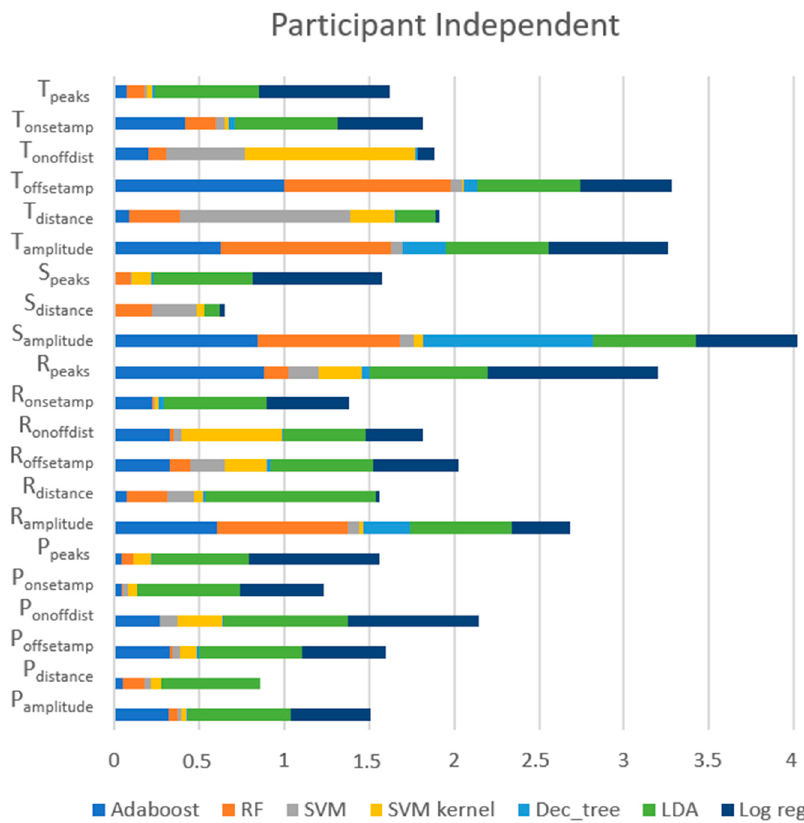
Figure 13. Importance of features for each model using the participant-independent approach.